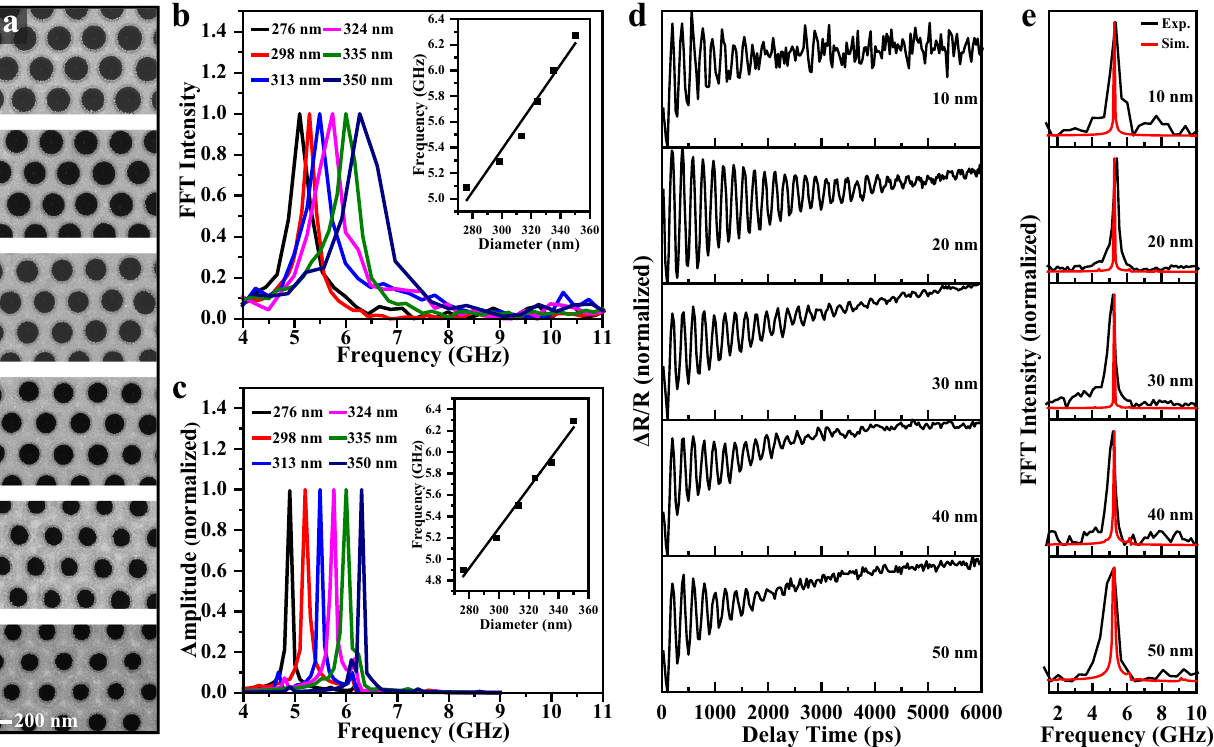
c Simulated frequency spectraof the TSNOMS with different nanohole diameters. d Transient re fl ection spectra of the optomechanical metasurface with varying thicknessofmetasurface. e FFTspectraofthemeasuredre fl ectionoptomechanical responses with different thicknesses. The black lines are experimental data, and the red lines are simulation